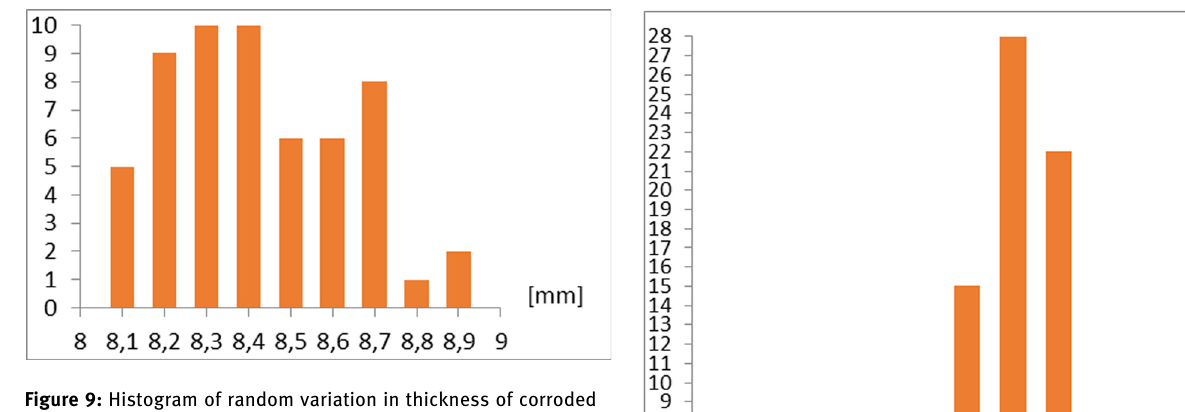
Figure 9: Histogram of random variation in thickness of corroded sheets obtained for the second coating sheet of the tank number 1. The measurements were taken in 2006. Mean value ( estimated from the sample ) 8.42 mm, standard deviation 0.21 mm, coe ffi cient of variation 0.025.